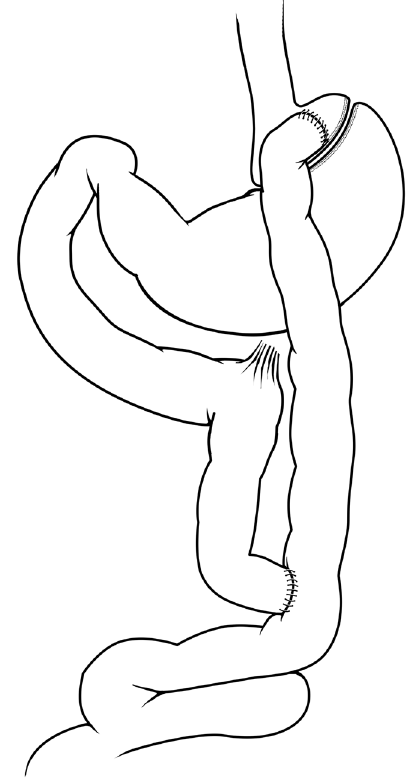
Figure 2. Roux-en-Y gastric bypass. The stomach is divided, creating a small gastric pouch (about 30 mL) that is connected via a gastrojejunostomy to a distal segment of jejunum, which forms the Roux limb of the procedure. The remainder of the stomach is referred to as the “gastric remnant” and drains into the bypassed portion of bowel, referred to as the “biliopancreatic limb”. Bowel continuity is restored for the biliopancreatic limb by a jejunojejunostomy, creating the “Y” configuration of the operation. Thus, ingested nutrients proceed rapidly through the stomach pouch and move immediately into the jejunal Roux limb in the absence of bile and pancreatic secretions. Bile and pancreatic secretions drain via the biliopancreatic limb and then mix with the chyme/nutrients at the point of the jejunojejunostomy. Reprinted with permission 35 .